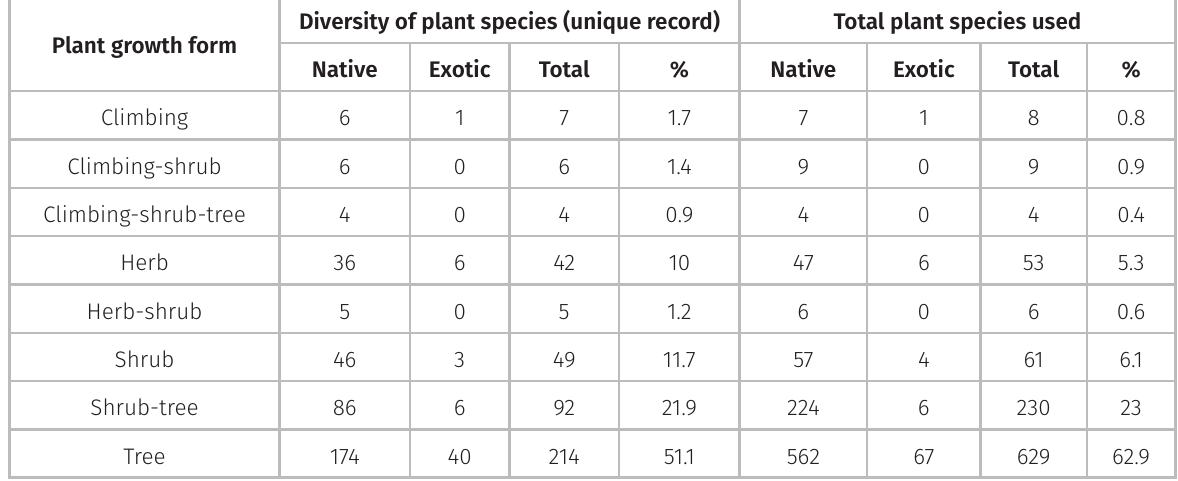
Table IV. The plant species growth form used in assisted regeneration of the Cerrado biome.